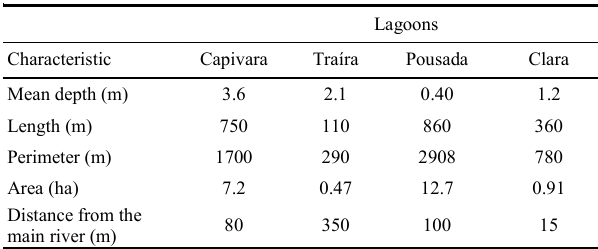
Table 1 . Physical characteristics of the lagoons sampled in the upper Paraná River floodplain.